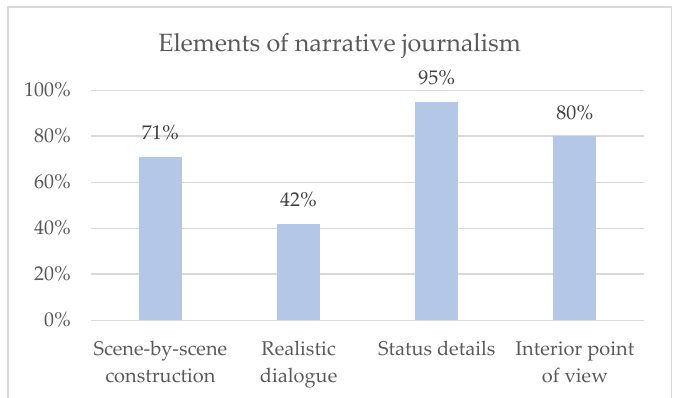
Figure 1. Presence of the elements of narrative journalism according to Tom Wolfe (1973) in the articles of the general analysis. Religions 2019 , 10 , x FOR PEER REVIEW